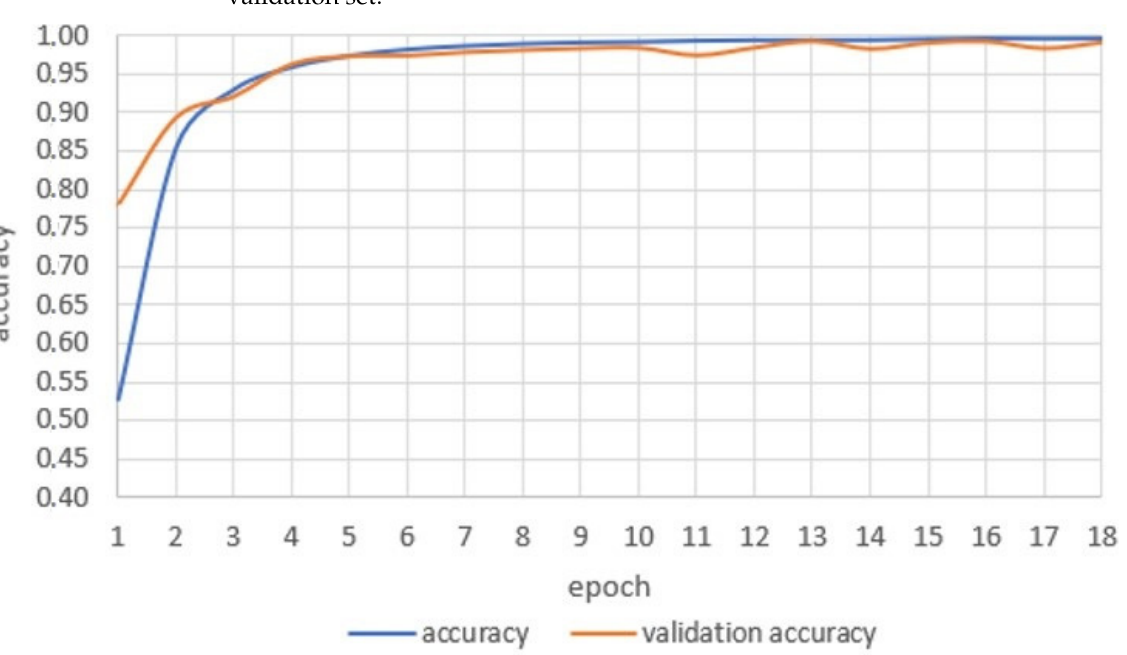
Figure 4. Comparison of the validity function of the answer with the validity function of the validation set. Starting from the third learning cycle, the values of both functions are similar. Based on the obtained results, it may be concluded that there is no overfitting phenomenon in the analysed network, and thus the network should have a high ability to recognize unknown objects. The created neural network was validated after the learning process. The size